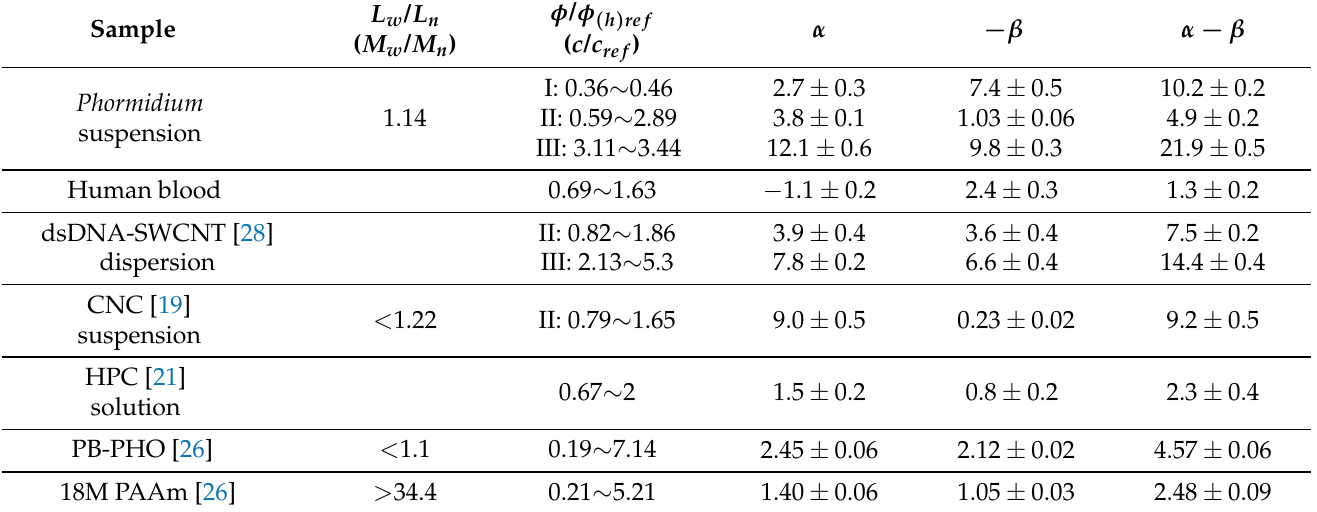
Table 3. The concentration scaling exponents α , − β and α − β of the shifting factors a c , b − 1 c and a c / b c , respectively. φ ref = 1.04% for dsDNA-SWCNT, φ ref = 6.3% for CNC suspension, c ref = 3 wt %